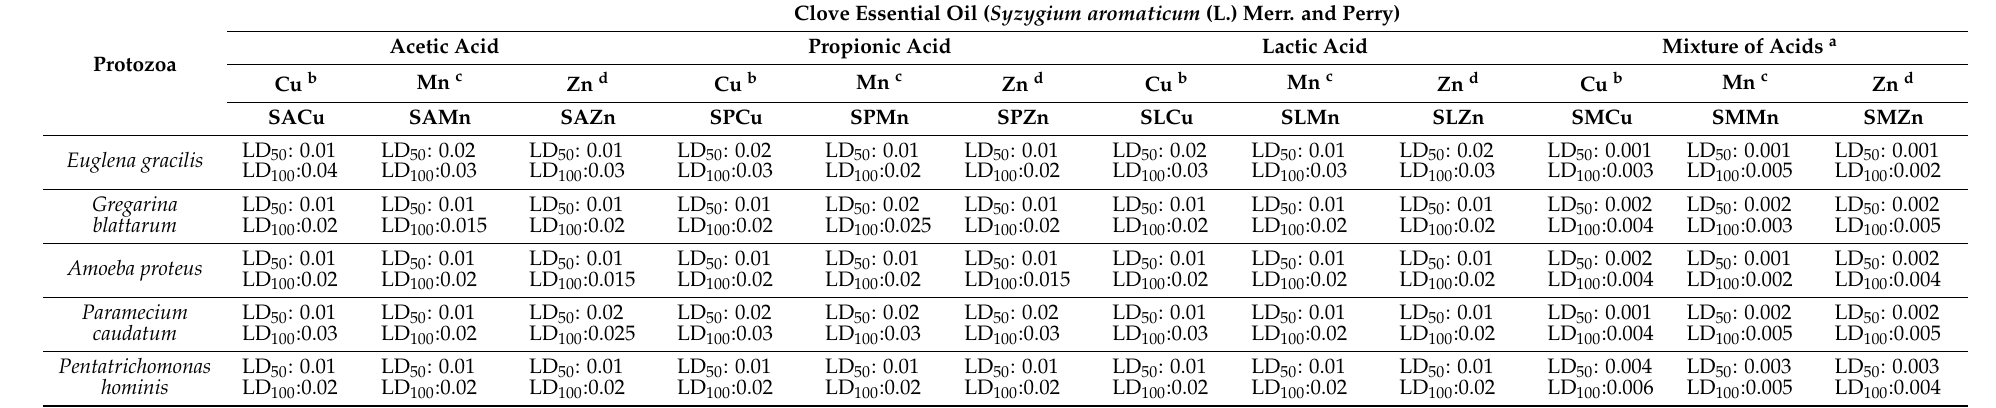
a —chloramphenicol, b —metronidazole, c —in rate 1:1:1, d —Manganese (II) chloride 10% solution, e —Copper (II) carbonate hydroxide 10% solution, f —Zinc carbonate 10% solution, g —5% solution, n.t—not tested. Table 3. LD 50 , LD 100 values [%], for the tested mixtures of clove essential oil ( Syzygium aromaticum (L.) Merr. and Perry) (S), organic acids (Acetic acid—A, Propionic acid—P, Lactic acid—L, Mixture of acids—M) and metal ion against selected protozoa. Clove Essential Oil ( Syzygium aromaticum (L.) Merr. and Perry) Acetic Protozoa